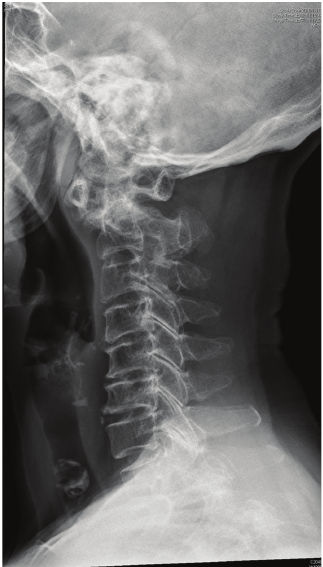
Figure 1: Increased distance at atlantoaxial space was